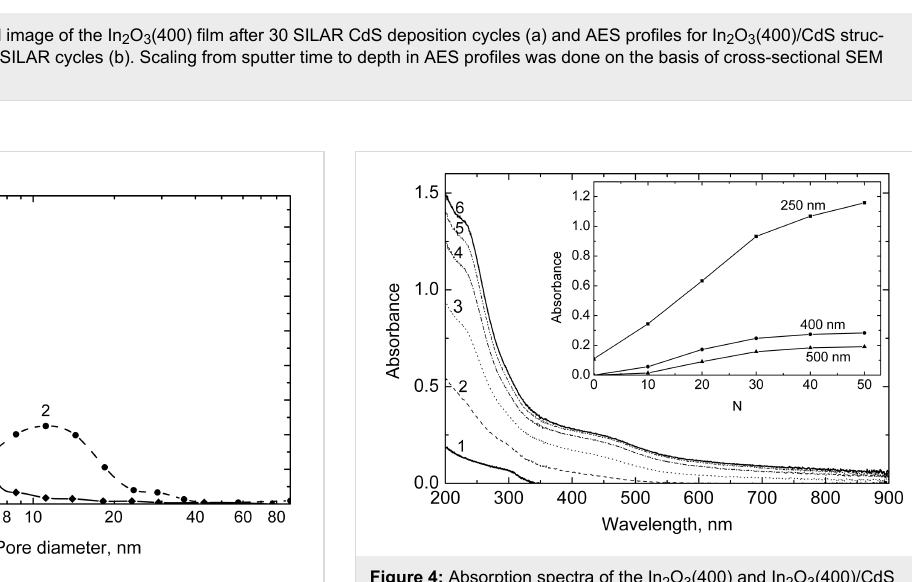
Figure 4: Absorption spectra of the In 2 O 3 (400) and In 2 O 3 (400)/CdS films deposited onto a quartz substrate. The number of SILAR cycles of the CdS deposition are as follows: 0 (1); 10 (2); 20 (3); 30 (4); 40 (5); 50 (6). The inset shows the dependencies of the absorbance at different wavelengths on the number of SILAR